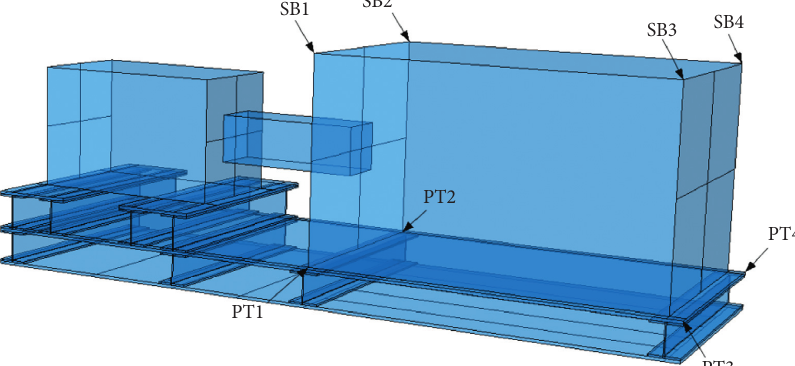
Figure 4: Locations of displacement measurement